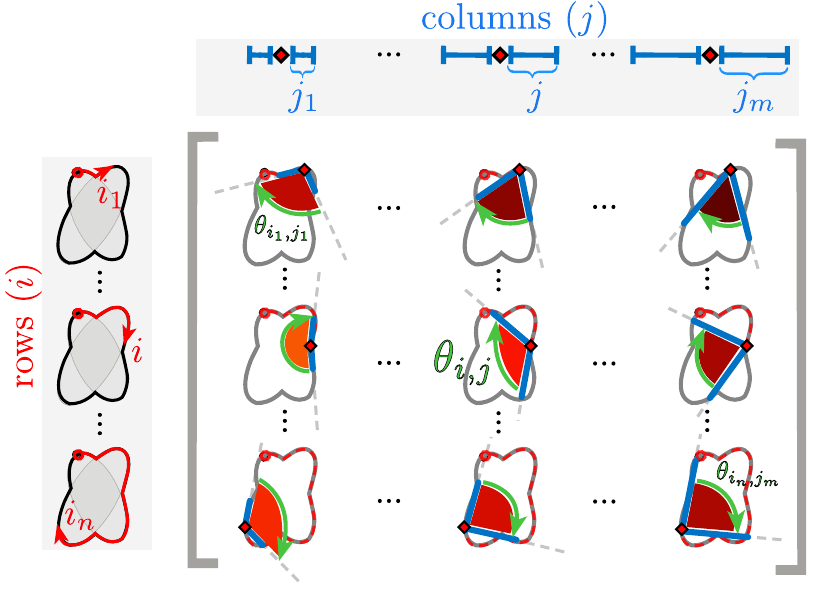
Figure 6. Explanation of inner angle of a point in the construction of the anglegram . The diagram shows a representation of nine arbitrary entries θ i , j of the anglegram matrix. Each entry corresponds to an inner point angle at a specific separation . In the diagram, as in the matrix, the rows ( i ) correspond to a single point alongside the boundary (red ) that start at a specific point (marked ); the columns ( j ) (cid:5) ◦ ˛ ˝ correspond to the separation from the point i and from there the angle is taken. Each corresponding entry, θ i , j , of the anglegram matrix Θ is marked with a green arrow, furthermore, each angle is shaded to match the colour map used in the anglegram in Figure 7.